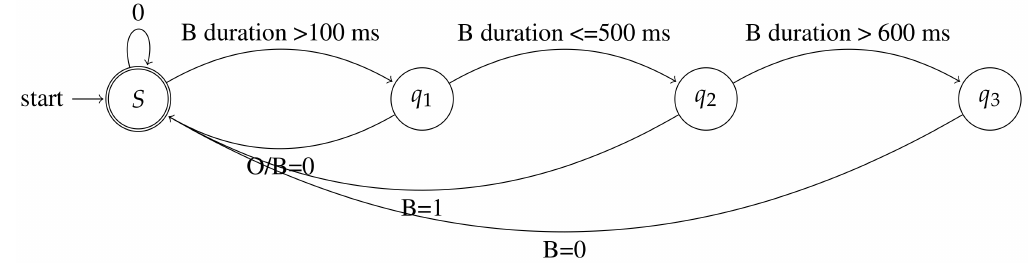
Figure 4. Blink peak width calculation using the full width at half maximum (fwhm).